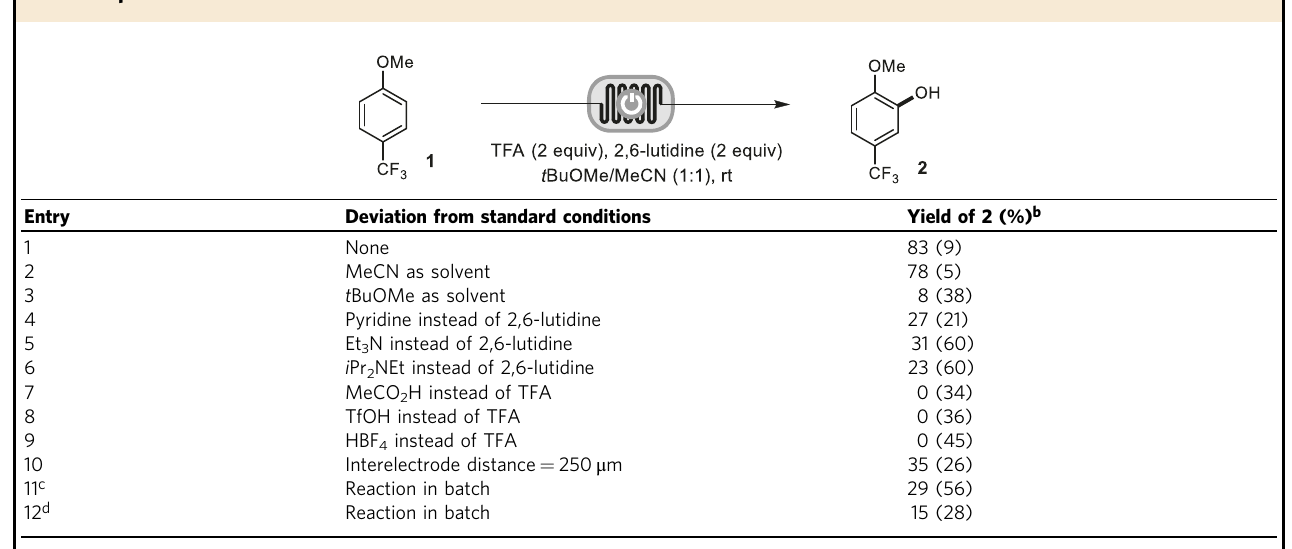
Table 1 Optimization of reaction conditions a